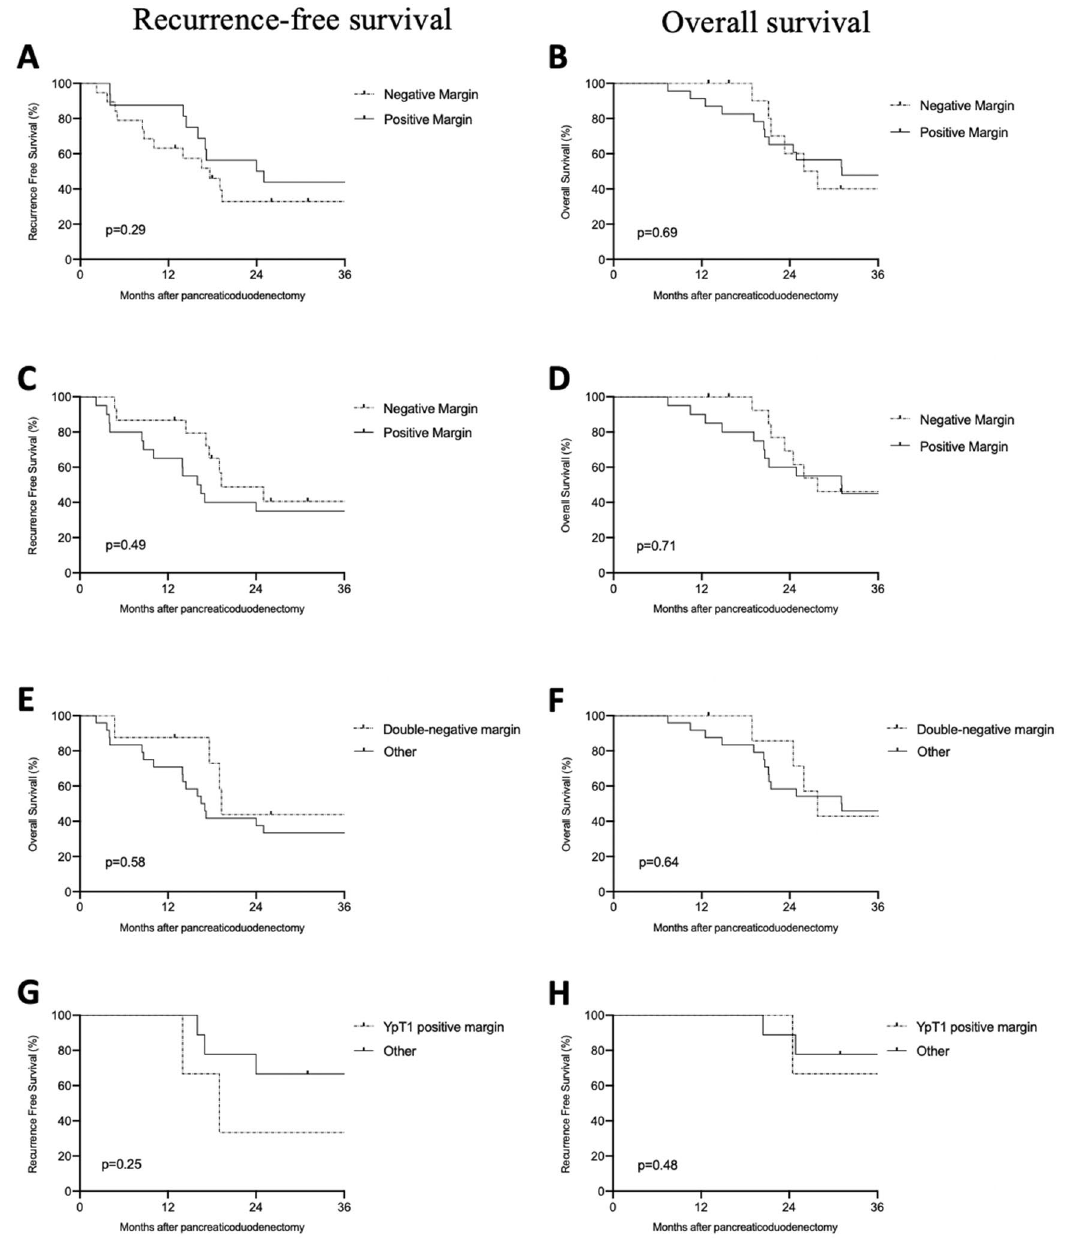
Figure 4. Kaplan–Meier survival analysis based on the molecular resection margin status. ( A ) Recurrence-free survival for resection margin, ( B ) Overall survival for resection margin, ( C ) Recurrence-free survival for venous margin, ( D ) Overall survival for venous margin, ( E ) Recurrence-free survival for double-negative margin, ( F ) Overall survival for double-negative margin, ( G ) Recurrence-free survival for ypT1venous and/or resection- positive margins, ( H ) Overall survival for ypT1venous and/or resection-positive